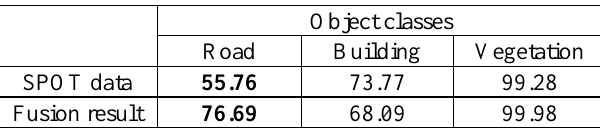
Table 4. Quality of the SPOT classification and decision fusion